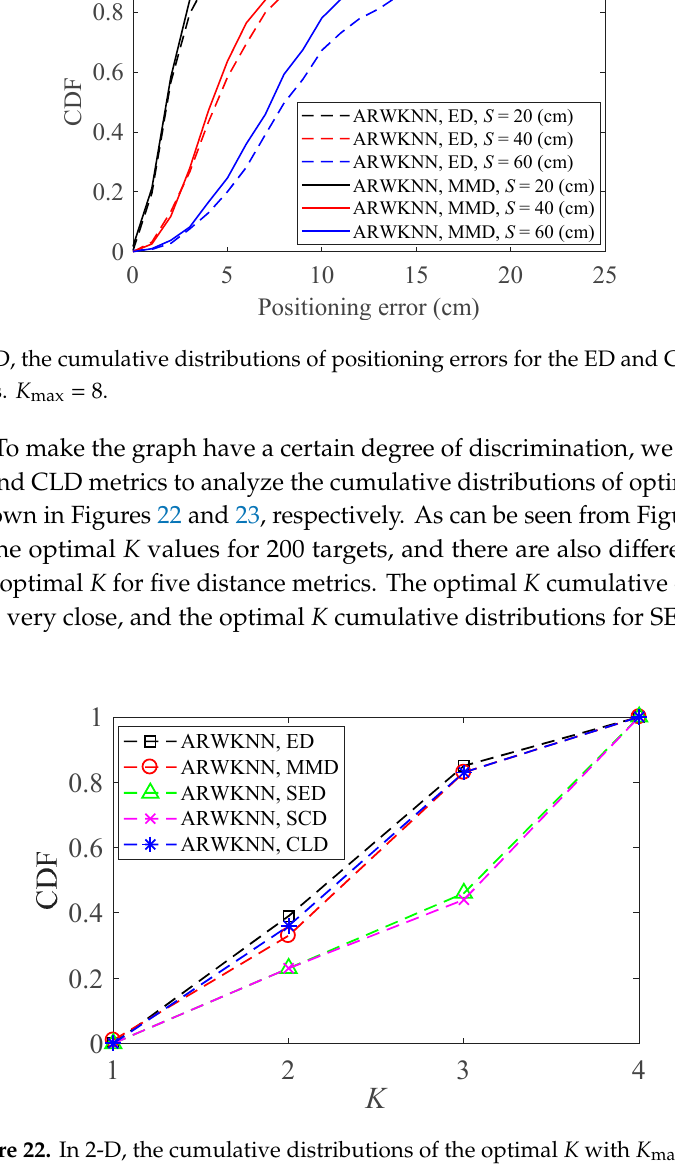
Figure 22. In 2-D, the cumulative distributions of the optimal K with K max = 4.